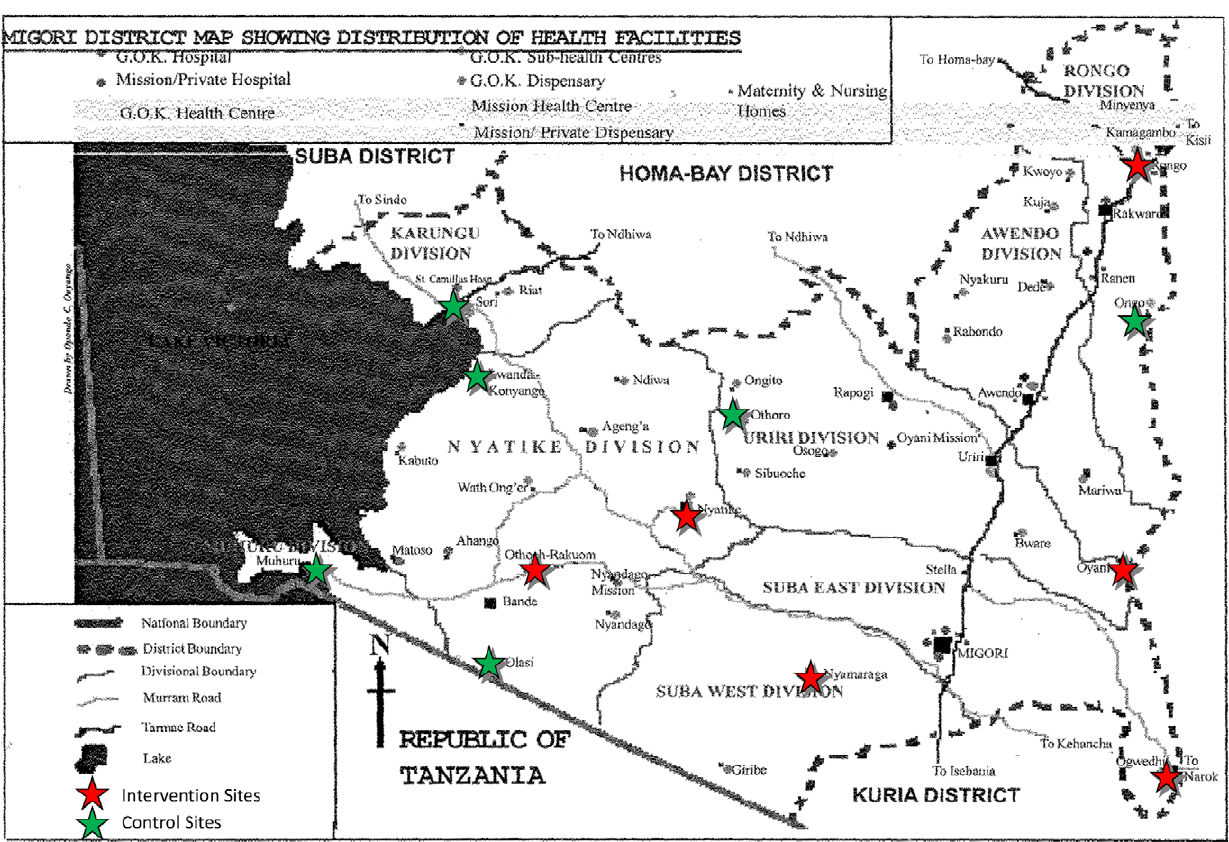
Figure 1. Map of SHAIP Study Sites. This map of the Greater Migori District shows the location of control (NI, indicated by green stars) and intervention (FI, indicated by red stars) health facilities.